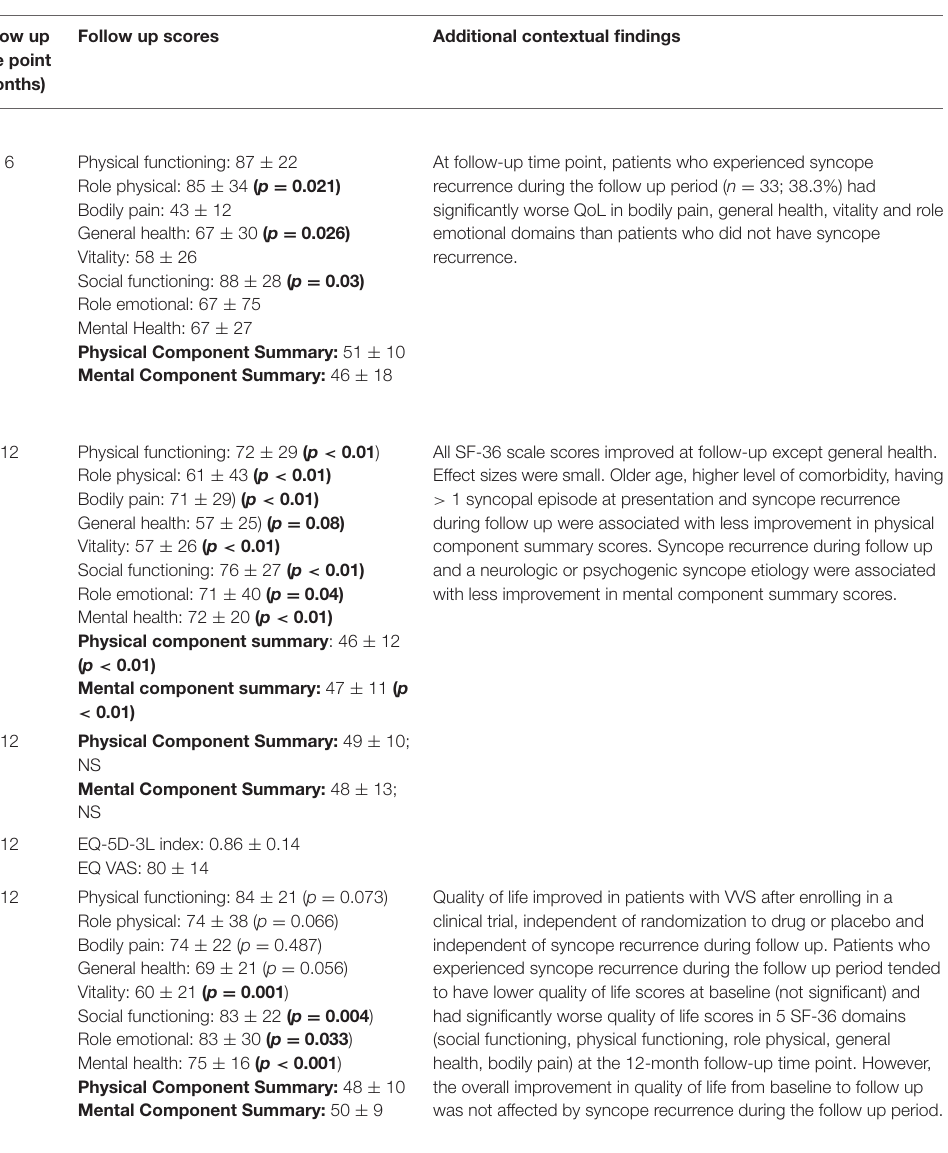
TABLE 3 | Longitudinal study